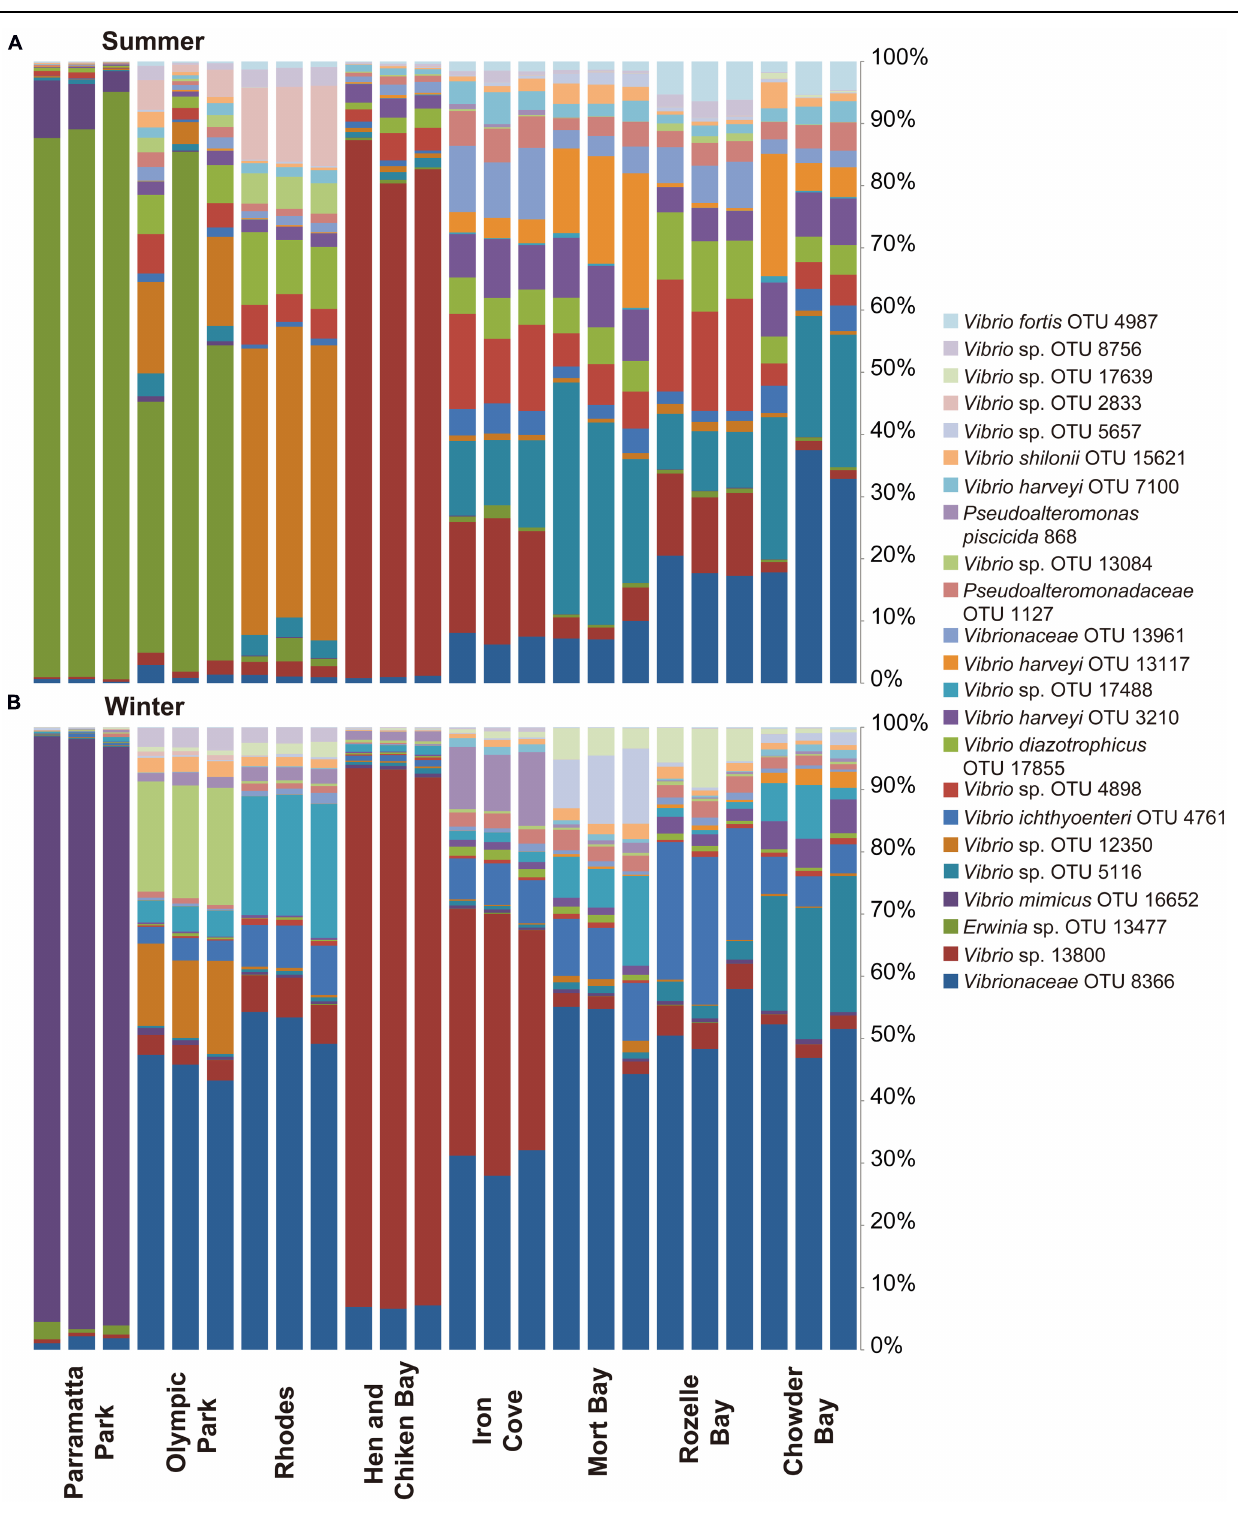
Frontiers in Microbiology | www.frontiersin.org